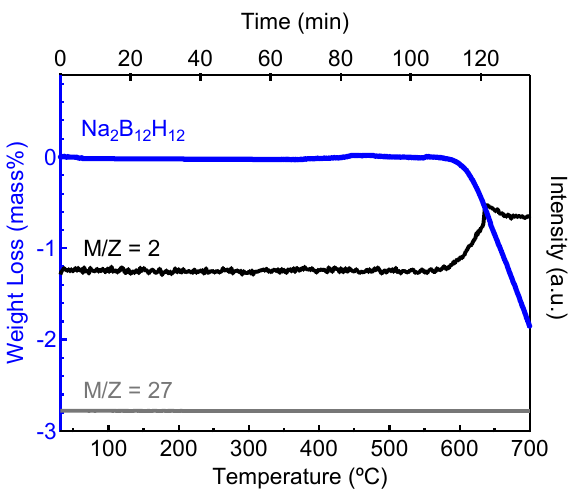
Figure 4. TG curve and MS signals of anhydrous Na 2 B 12 H 12 (mass numbers 2 and 27 represent H 2 and B 2 H 6 ).